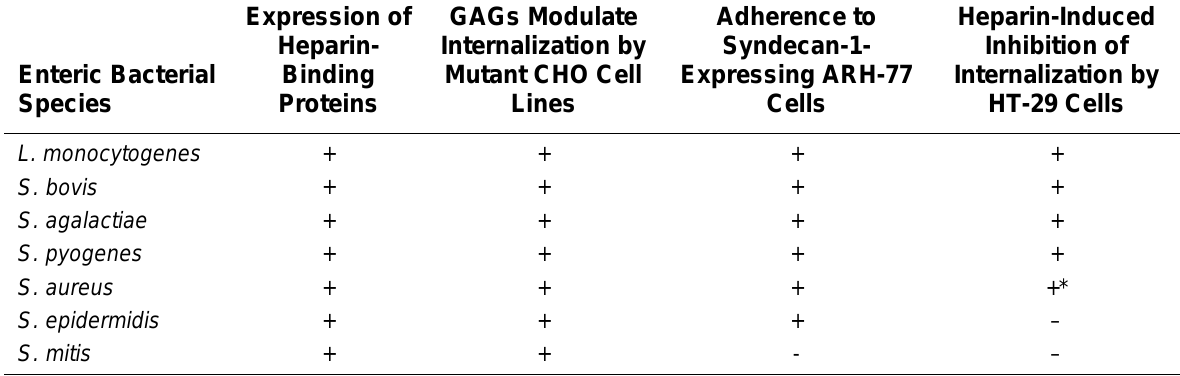
Summarized Results[9] of Assays Designed to Detect Bacterial Expression of Heparin-Binding Proteins and to Quantify the Ability of GAG Expression by Mutant Chinese Hamster Ovary (CHO) Cells to Modulate Bacterial Internalization, the Ability of Bacteria to Show Increased Adherence to ARH-77 Cells Transfected to Express Syndecan-1, and the Ability of Exogenous Heparin to Inhibit Bacterial Internalization by HT-29 Enterocytes (a Cell Line with Prominent Syndecan-1 Expression). E. coli, P. vulgaris, P. mirabilis, K. pneumoniae, C. freundii, E. cloacae, S. typhimurium, and E. faecalis (not included below) Gave Negative Results in All Assays